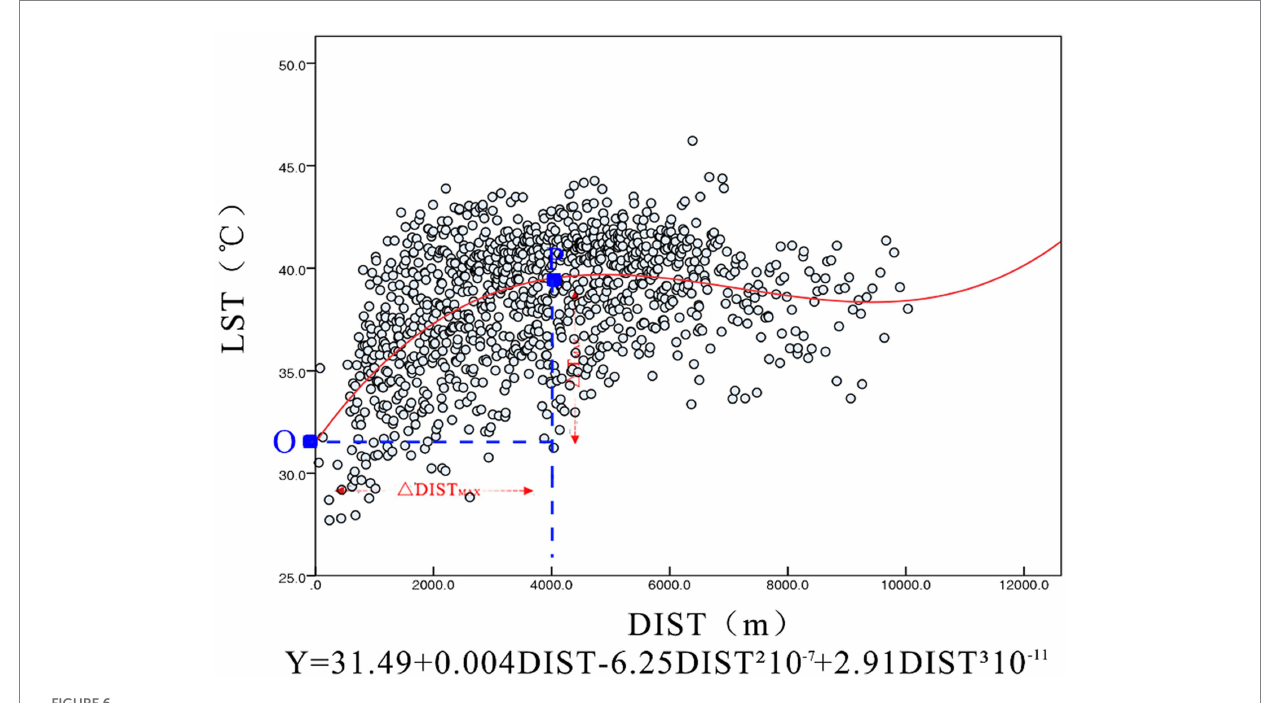
FIGURE 6 Scattered plot of offshore distance and temperature.